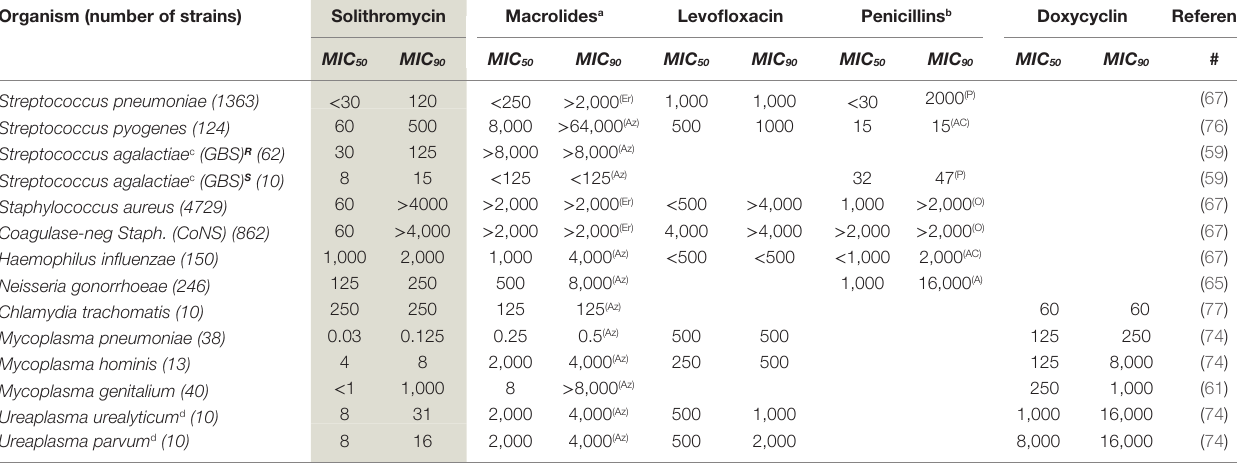
TABLe 1 | Comparison of antimicrobial efficacy (MiC 50 and MiC 90 values) of solithromycin vs. four other relevant antibiotics against a range of important bacteria. Organism (number of strains) Solithromycin Macrolides a Levofloxacin Penicillins b Doxycyclin